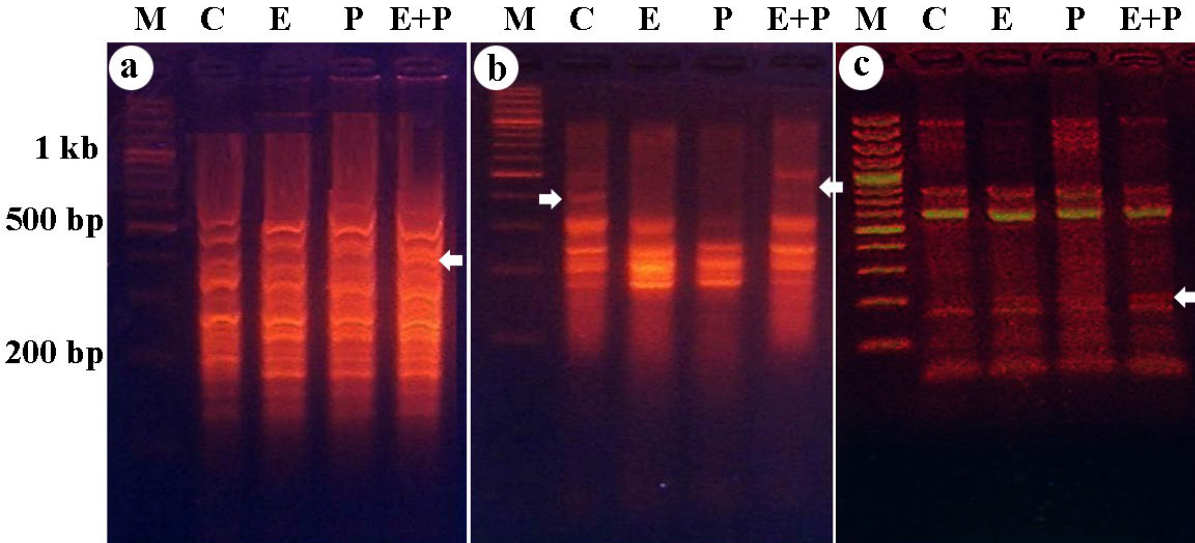
Figure 1. DNA fingerprinting of the DD-PCR using different arbitrary primers; A2 (a), A4 (b), and R2 (c) with reference to the selected bands for sequencing (arrows). M, 1.5 Kbp DNA marker; 1; untreated plant (C); 2, plant treated with turmeric extract (E); 3, plant inoculated with Fusarium solani (P), and 4, plant inoculated with F solani and treated with turmeric extract